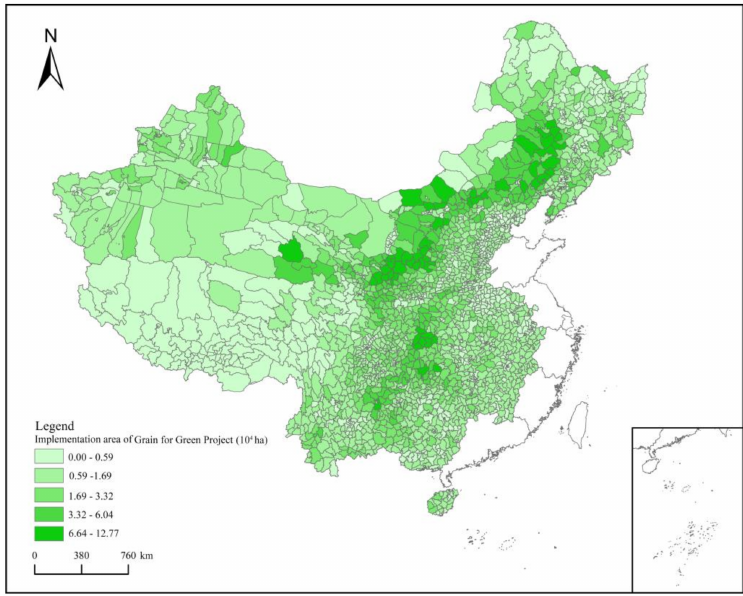
Figure 1. Area of the Grain for Green Project.